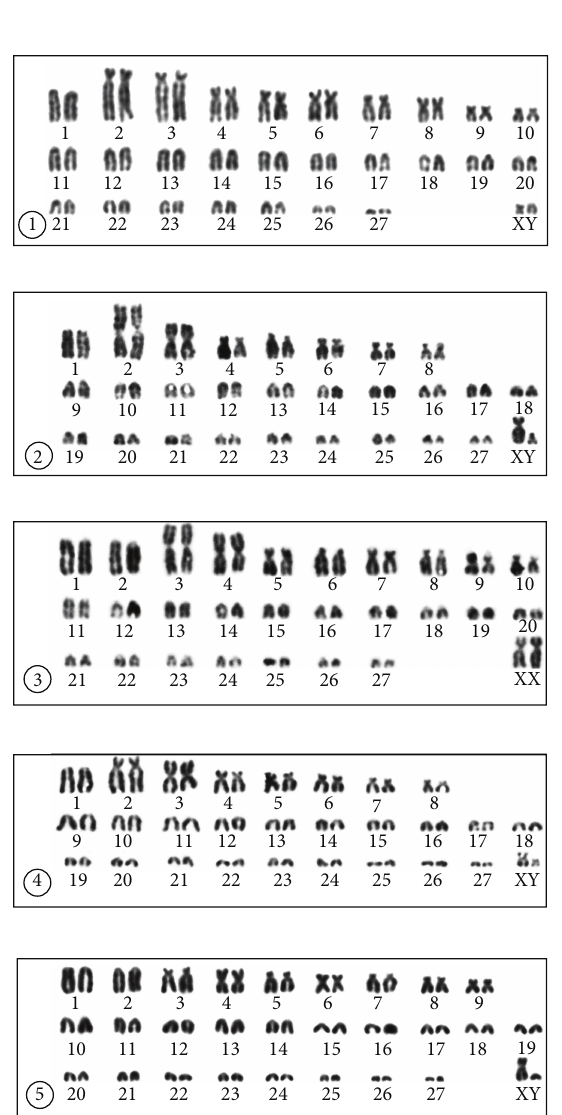
Figure 2: Standard karyotypes of specimens of Nannospalax leu- codon from Babaeski (1) and N. xanthodon from Kula (2), Alas¸ehir (3), Yılanlı (4), and G¨ulek